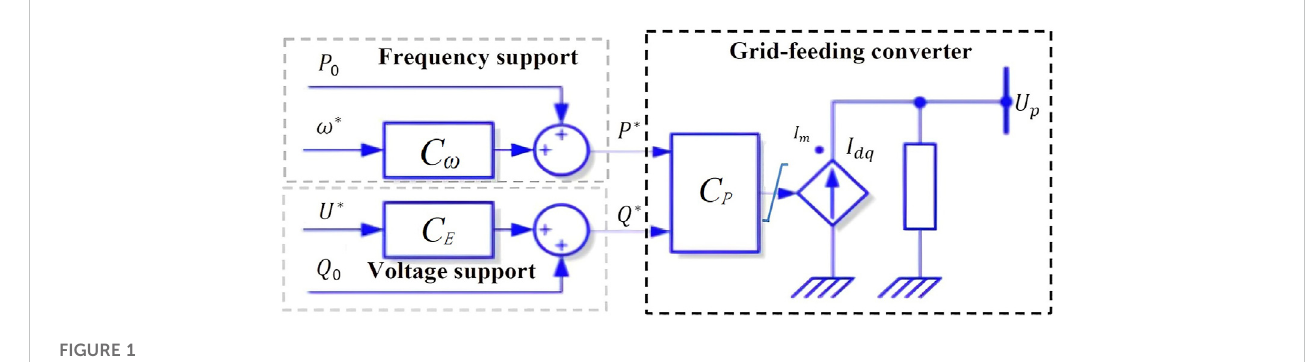
FIGURE 1 Grid-feeding